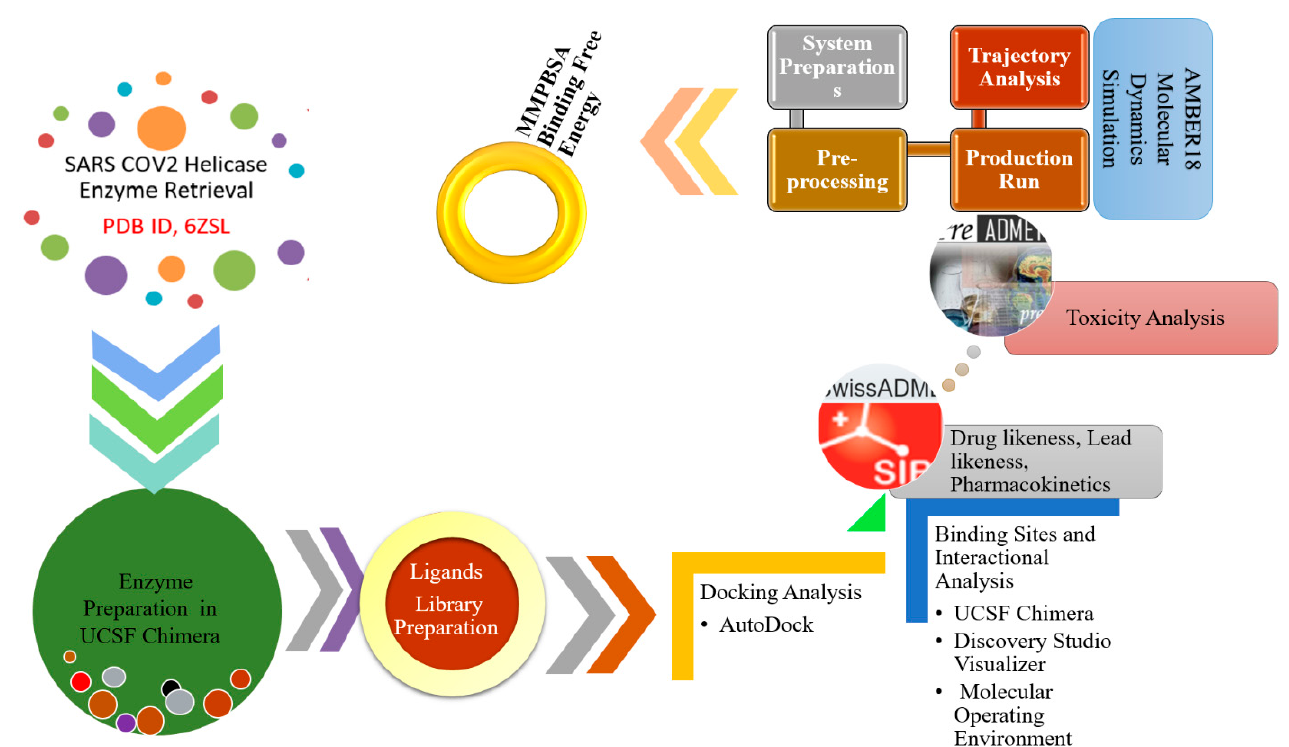
Figure 1. Flowchart of the methodology employed in the present study.